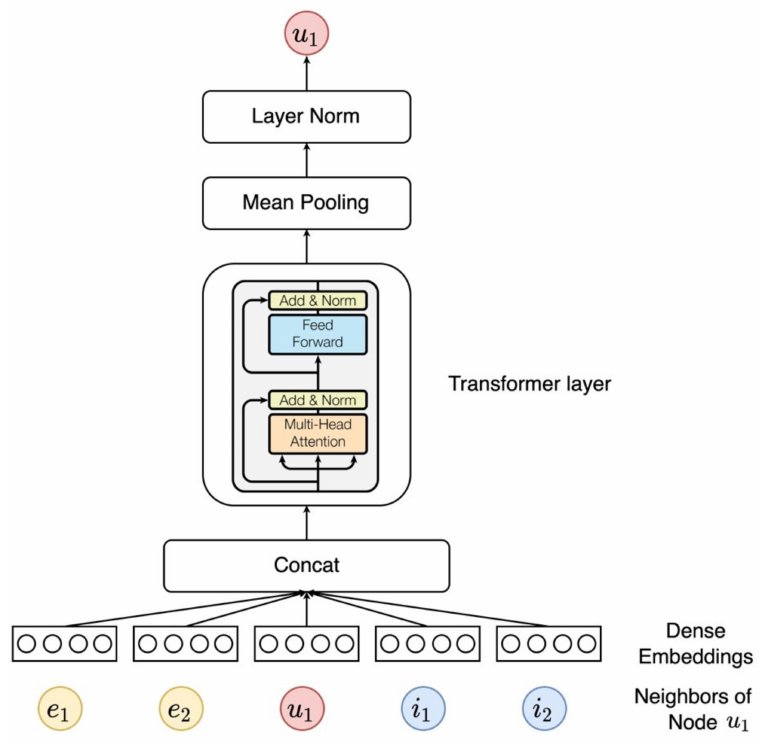
Figure 6. Transformer